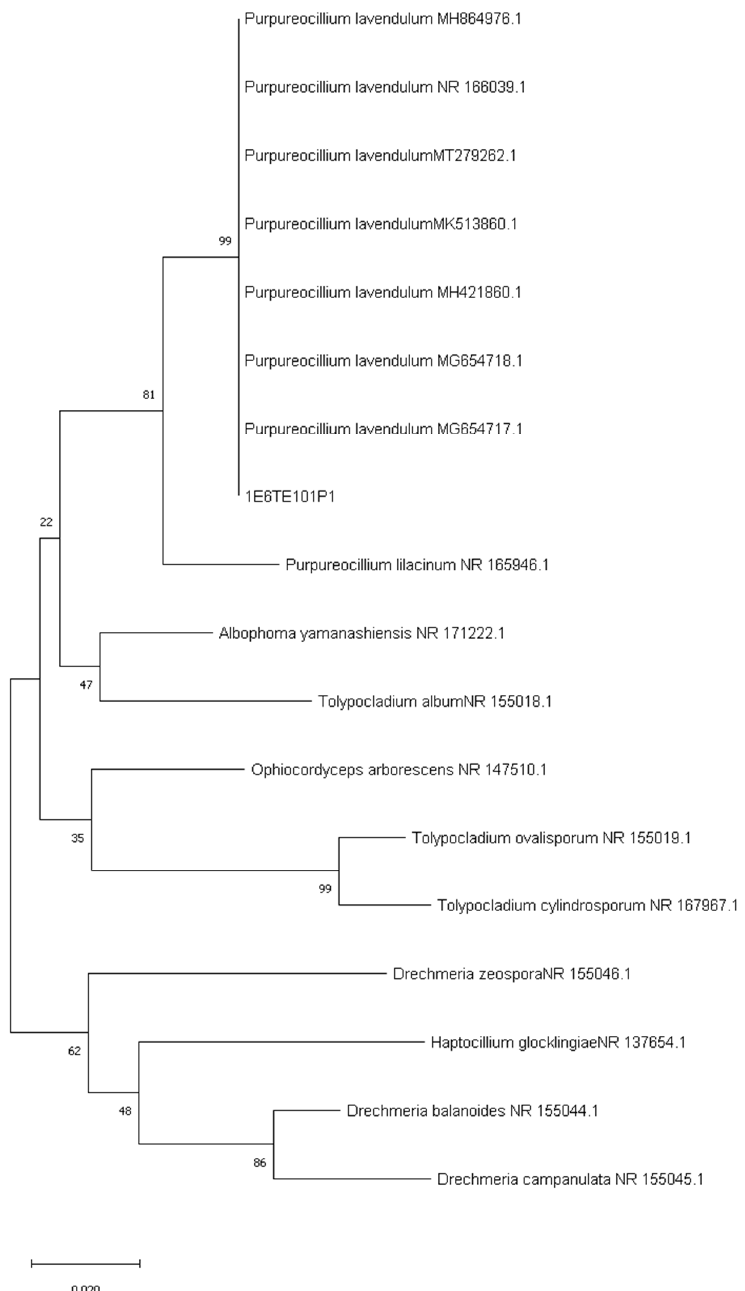
Figure 4. Phylogenetic tree of P. lavendulum with the new isolate from Greece (1E6TE101P1 (GenBank accession MZ047311) and related species from GenBank. The species names are followed by the GenBank accession numbers.